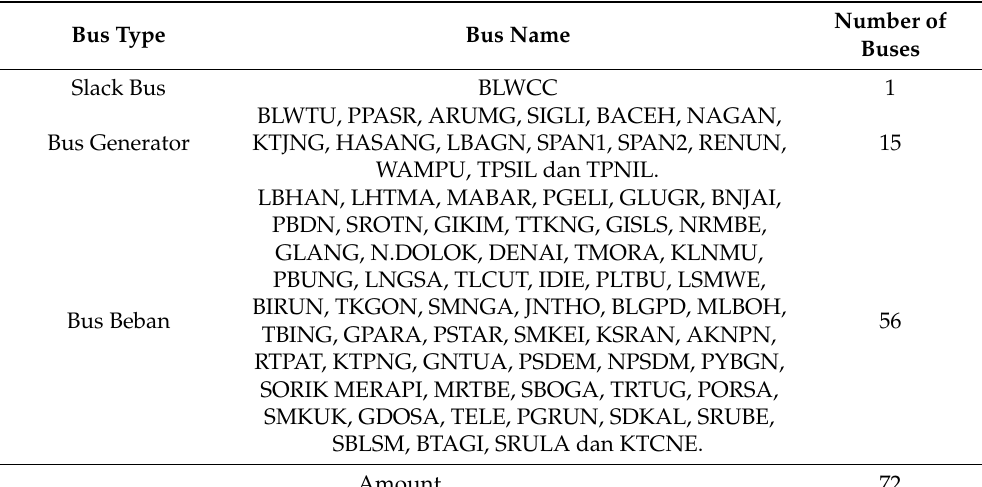
Figure 1. Single line diagram of the SUMBAGUT 150 kV. Table 1. Classification of Bus Types in the SUMBAGUT 150 kV.